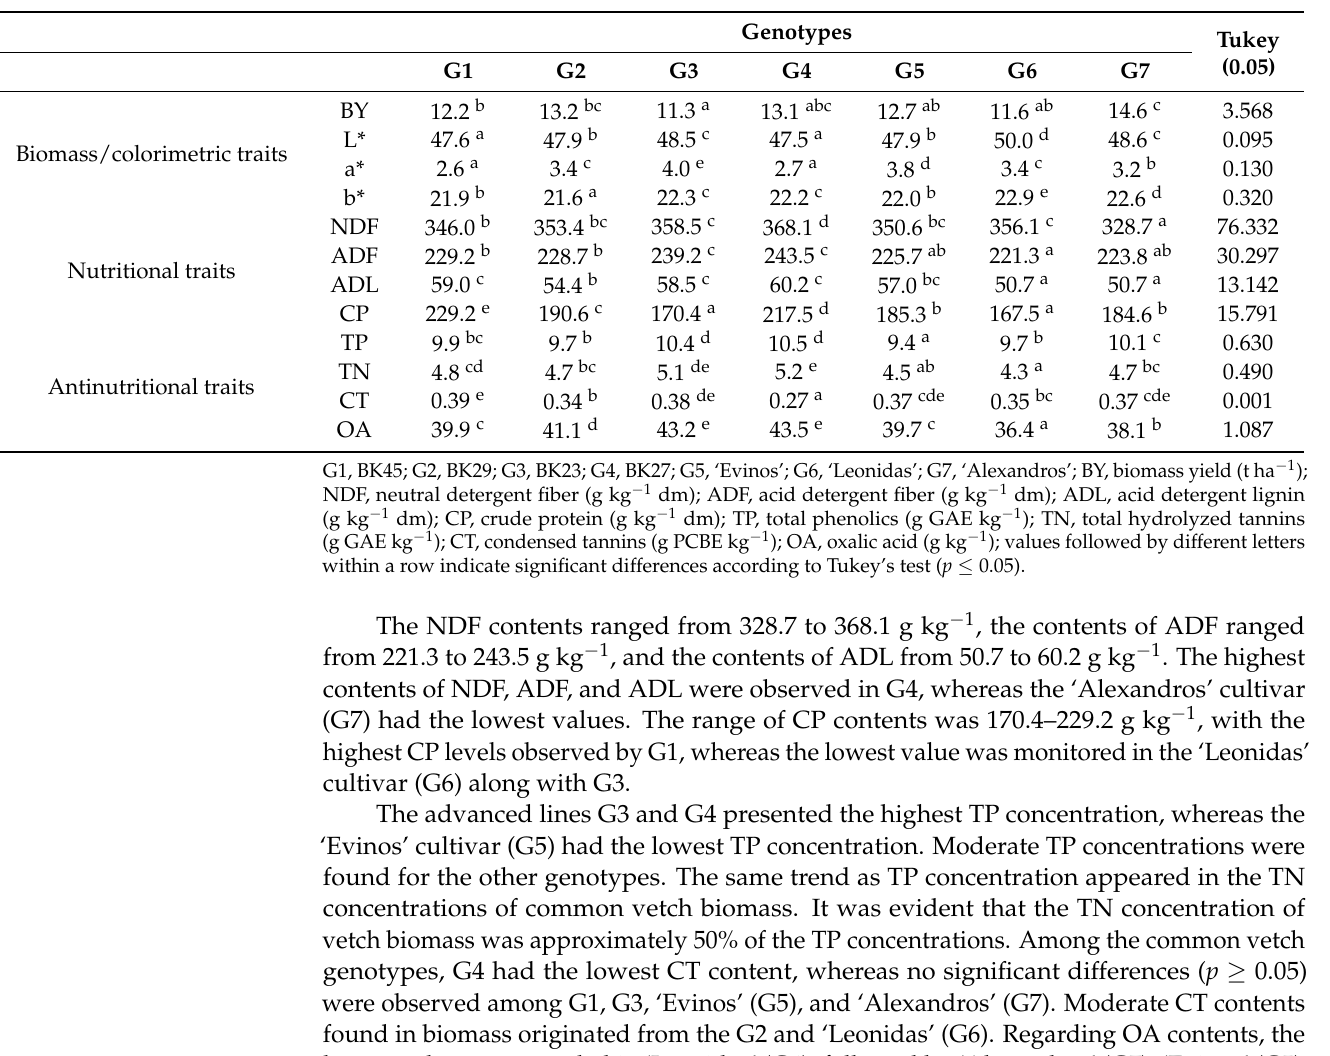
Table 4. Variation in biomass/colorimetric, nutritional and antinutritional traits of V. sativa biomass originated from seven genotypes averaged across